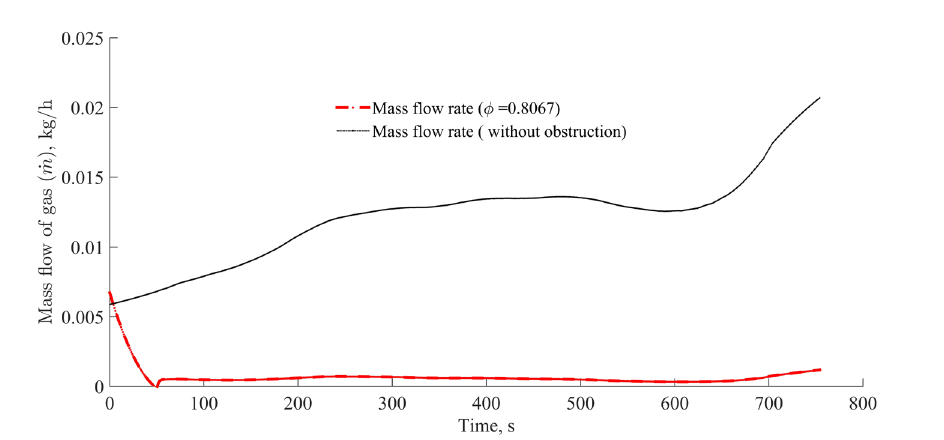
Fig. 12. Comparative illustration of flow medium (varying density of